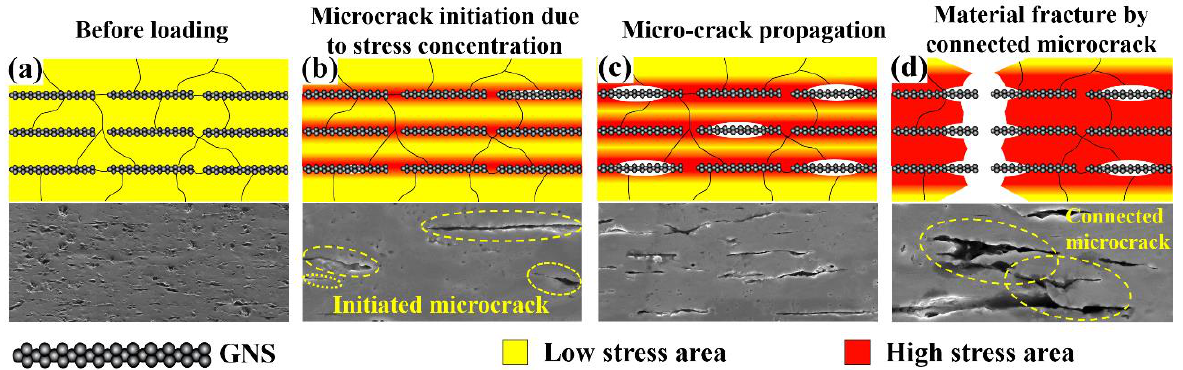
Figure 9. Schematic diagram of fracture mode of the GNS/Cu composites. ( a ) GNS/Cu composite before loading, ( b ) initiation of microcrack around the GNSs under applied load, ( c ) migration of microcrack in the GNS/Cu composite, and ( d ) connection of microcracks and fracture of the sample.